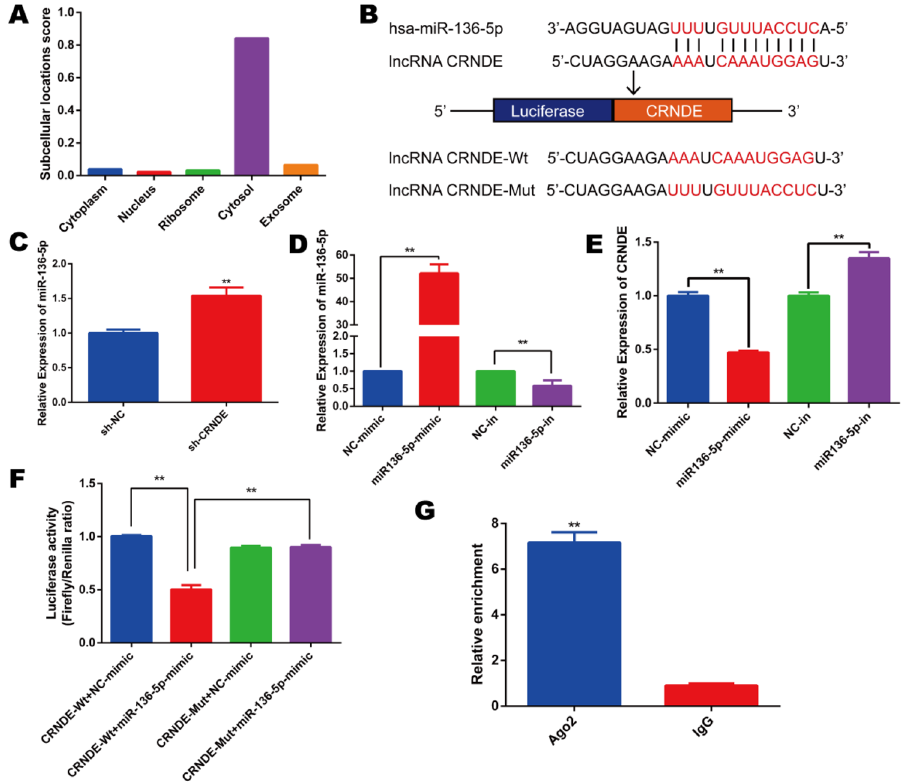
Figure 3. CRNDE binds to miR-136-5p. ( a ) The subcellular localization of CRNDE was predicted by lncLocator (http:// www. csbio. sjtu. edu. cn/ bioinf/ lncLo cator/). ( b ) The binding sites between CRNDE and miR- 136-5p were predicted by Starbase V3.0 (http:// starb ase. sysu. edu. cn/) and LncBase V2.0 (http:// carol ina. imis. athena- innov ation. gr/ diana_ tools/ web/ index. php?r= lncba sev2% 2Find ex- exper iment al). ( c ) QRT-PCR assay was used to detect the expression of miR-136-5p after knocking down CRNDE. ( d ) QRT-PCR assay was used to detect the transfection efficiency of miR-136-5p mimic and inhibitor. ( e ) QRT-PCR assay was used to